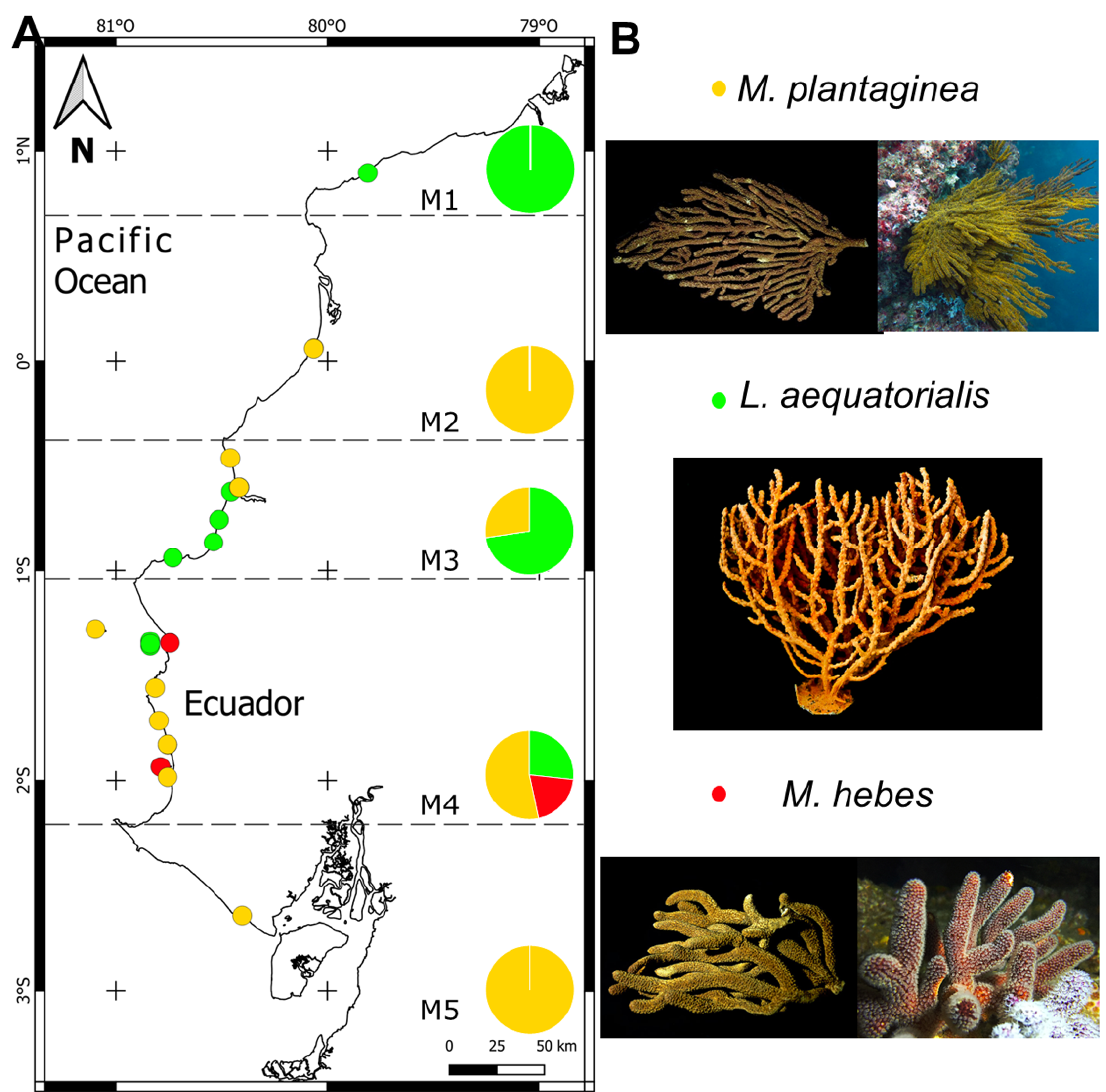
Figure 4. ( A ). Distribution map of the three targeted species: M. plantaginea (yellow dots), L. aequatorialis (green dots), and M. hebes (red dots) at the five macrozones on the mainland coast of Ecuador. ( B ) . In situ and ex situ pictures of the three targeted species. M. plantaginea images CC by K.B. Jaramillo, L. aequatorialis ex situ image CC by R. Abad, M. hebes in situ image CC by Juan Armando Sánchez, and ex situ image CC by CENAIM.